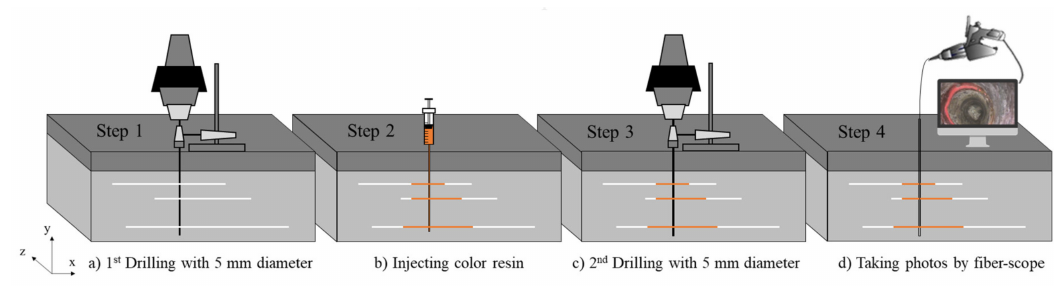
Figure 9. Visual rack inspection